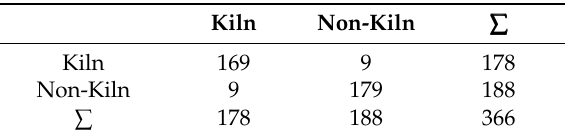
Table 2. Confusion matrix for the output of the analyses based on the CNN applied to the predictions from the Faster R-CNN. Layout as in Table